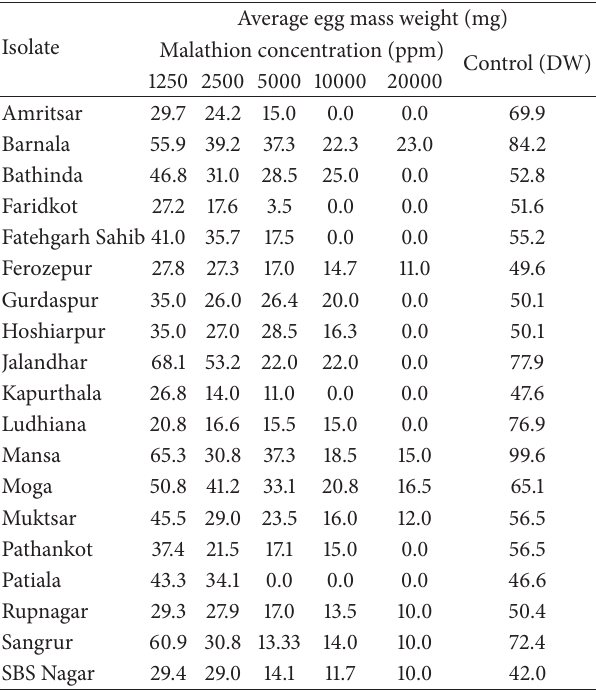
Table 2: Effect of malathion on egg mass weight of different isolates of R. ( B. ) microplus